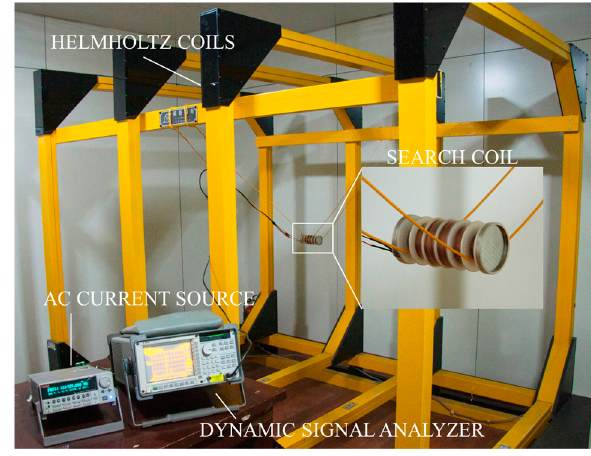
Figure 9. Overview of sensitivity experiment of core coil.